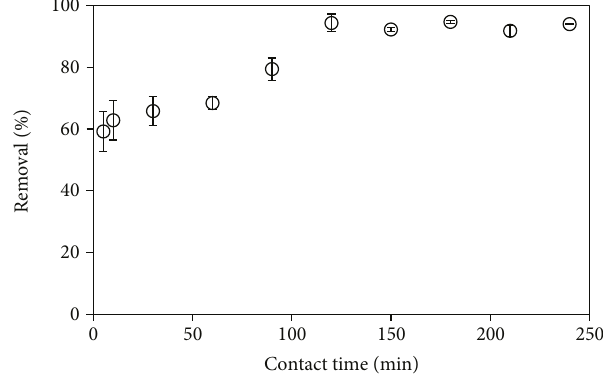
Figure 12: In fl uence of contact time on removal of Cd 2+ using surfactant-modi fi ed γ -Al 1 mM NaCl). Error bars show standard deviations of three replicates.